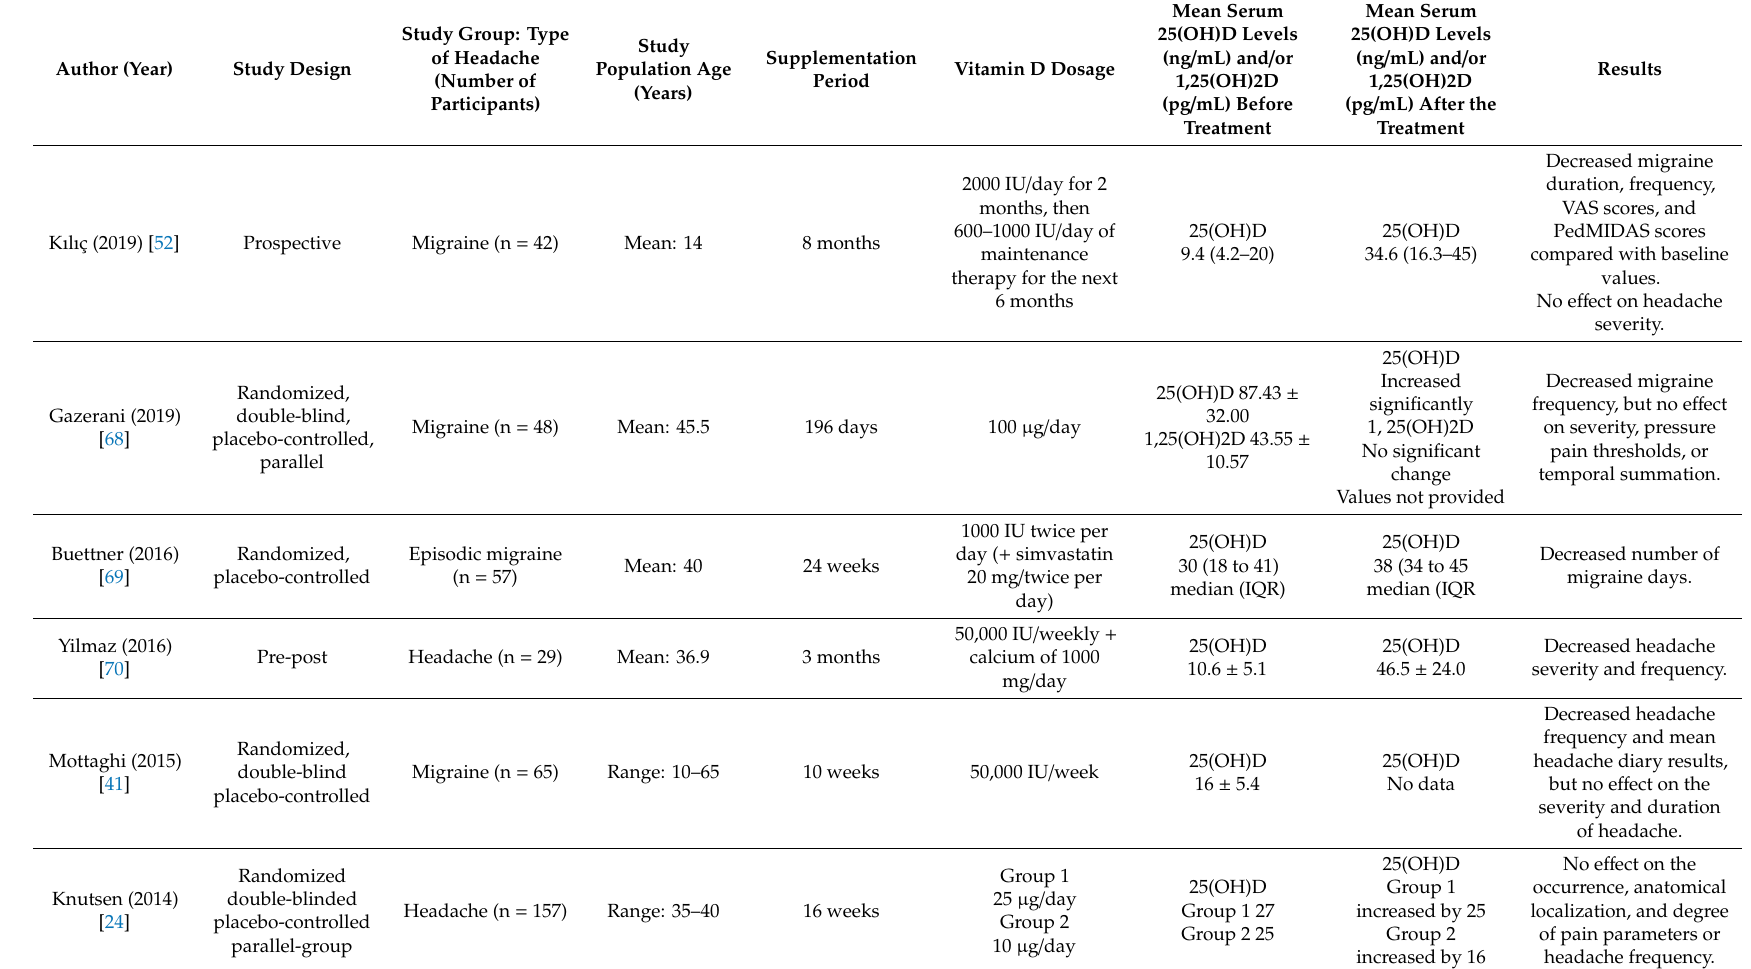
Table 2. Overview of studies evaluating the e ff ect of vitamin D supplementation on headache